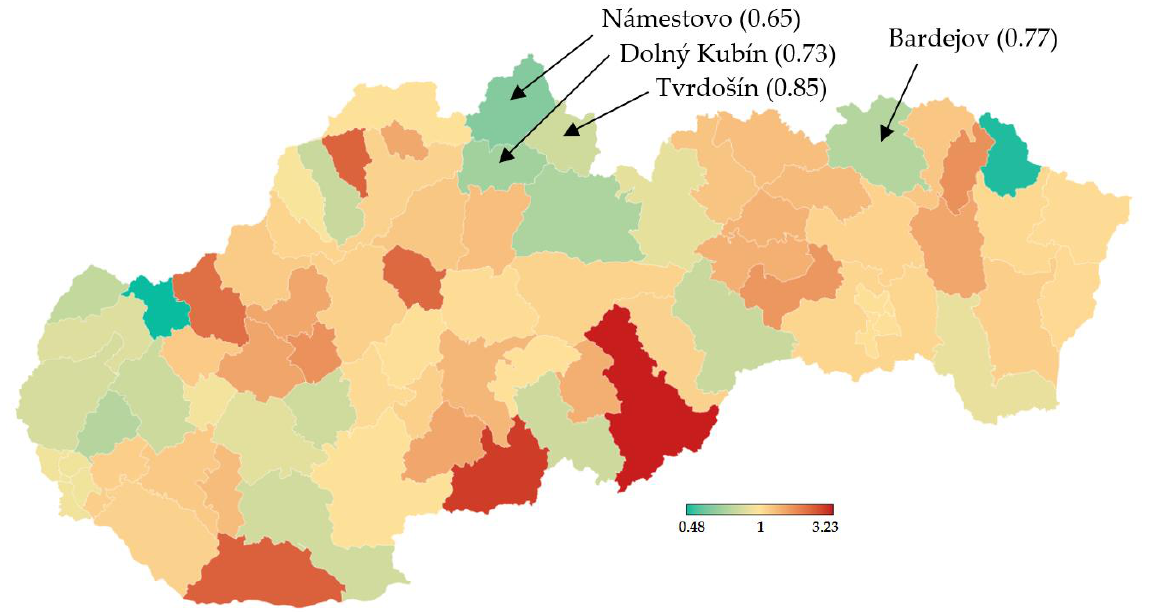
Figure 4. Multiplication of 7-day incidence- RT – PCR testing (28 November vs. 21 November) [20].